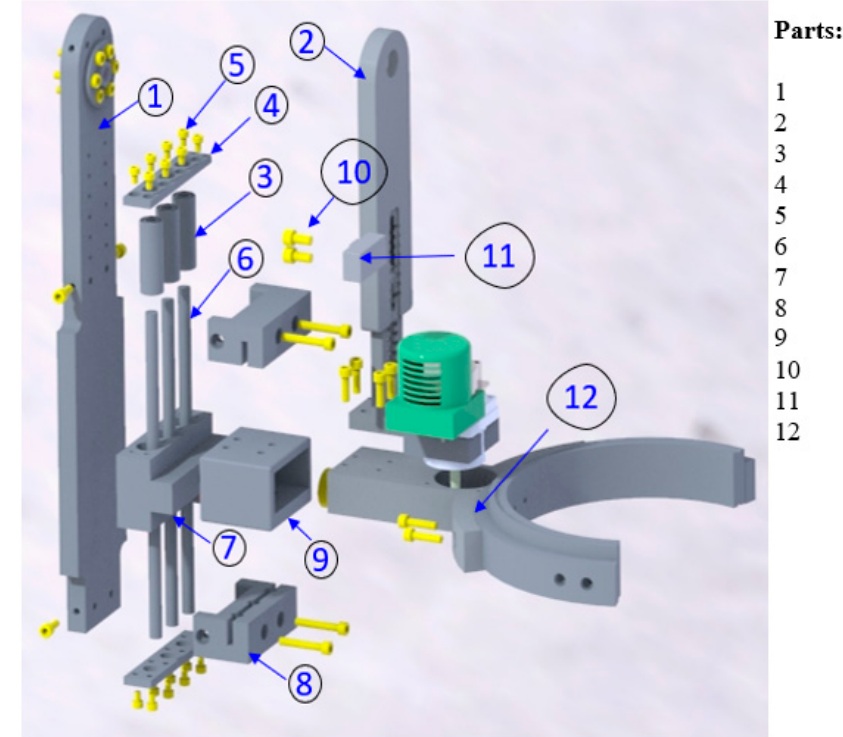
Figure 6. Exploded view of the sagittal mechanism.